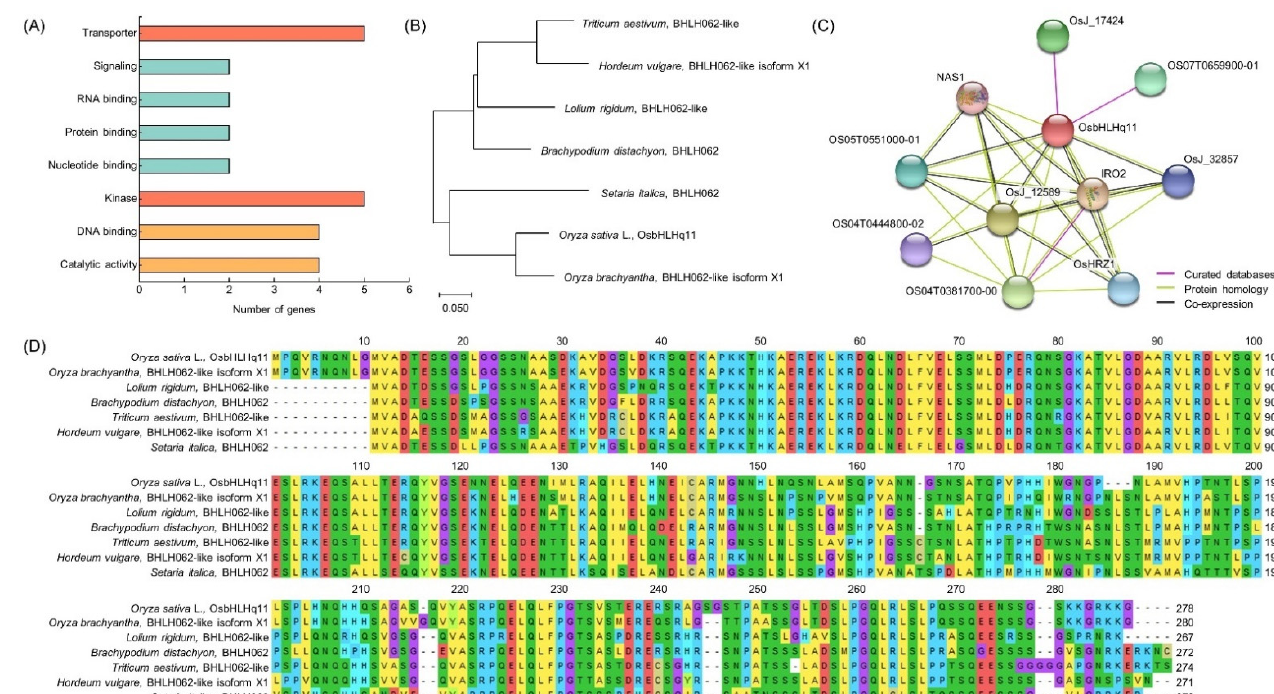
Figure 6. Analysis of relative expression level of 26 chlorophyll-related candidate genes. There were significant differences in LOC_Os11g34210 and LOC_Os11g38870. CNDH115 and CNDH11 are CNDH lines with high chlorophyll content (HC), and CNDH50-2 and CNDH52-2 are the CNDH lines with low chlorophyll content (LC). Means with the same letters were not significantly different by Duncan’s multiple range test at p < 0.05.